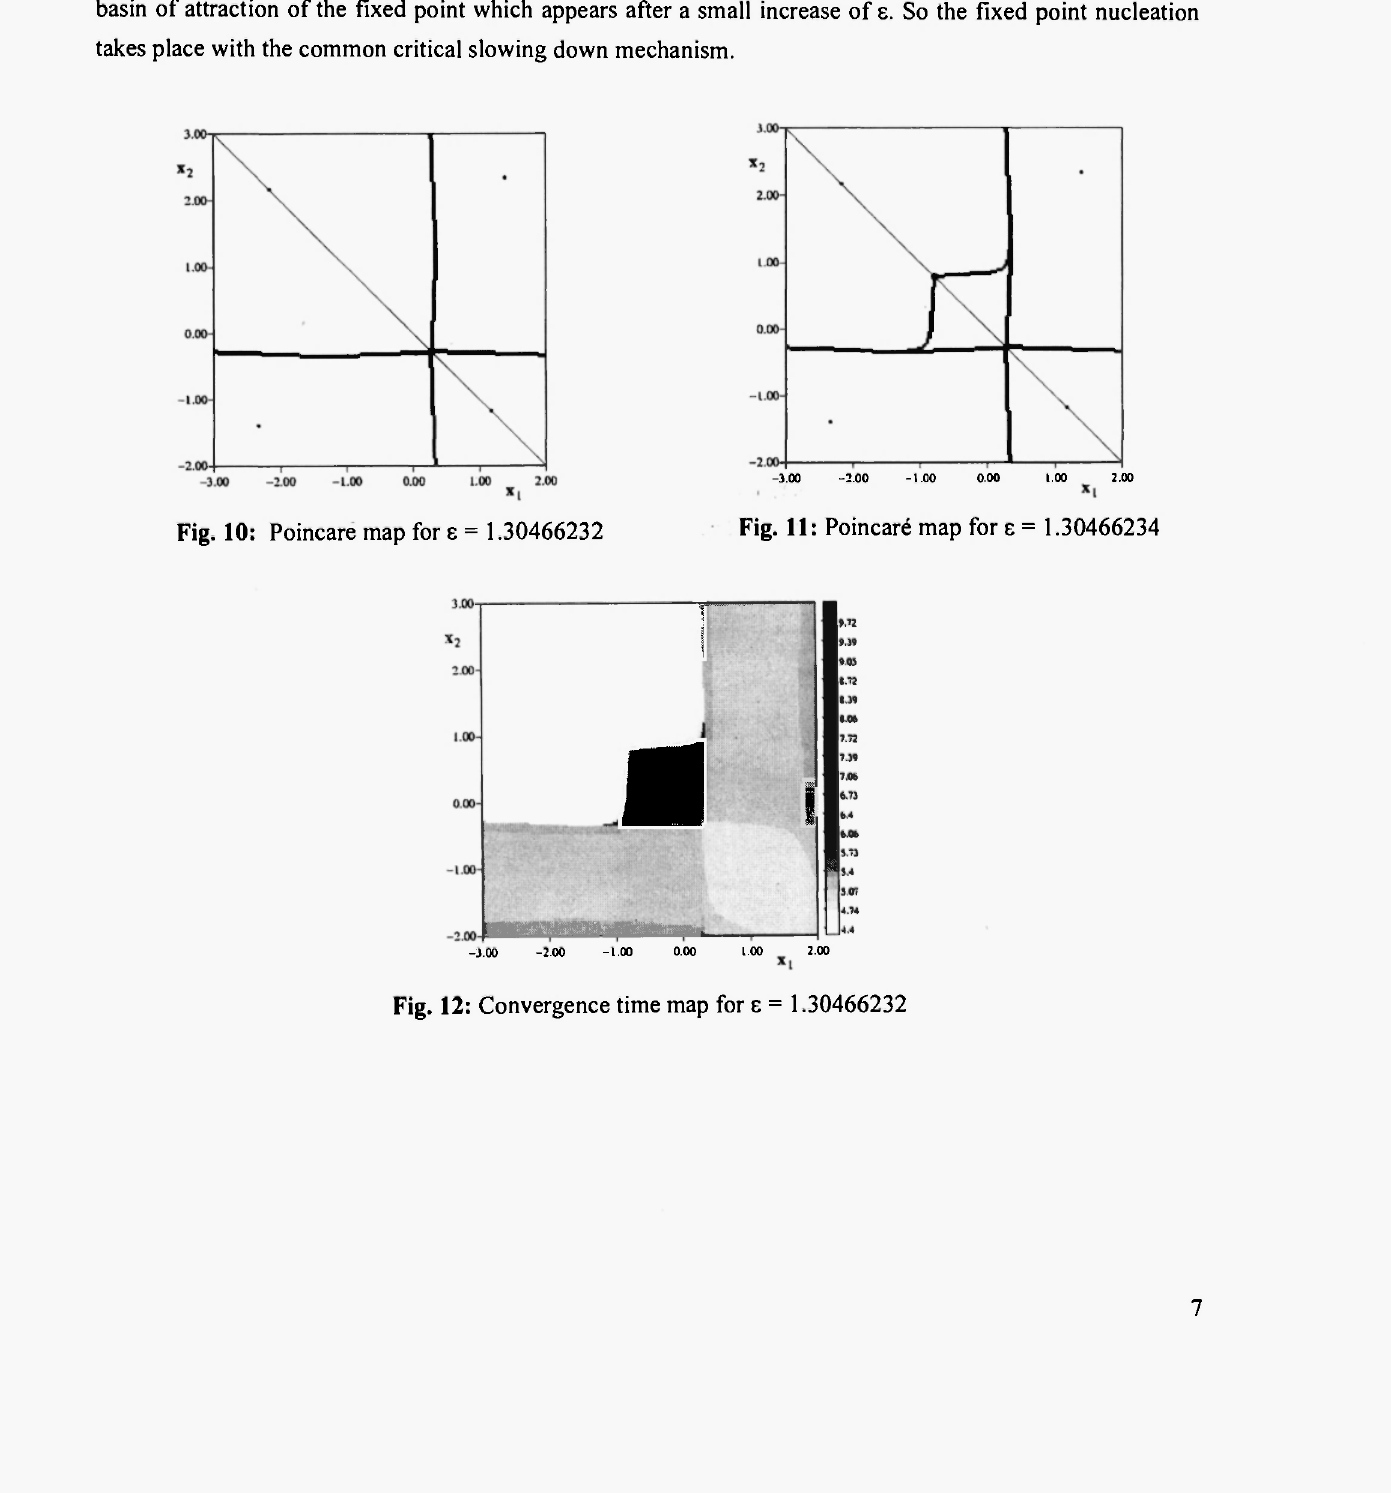
Fig. 10: Poincare map for ε = 1.30466232 Fig. 11: Poincar£ map for ε = 1.30466234